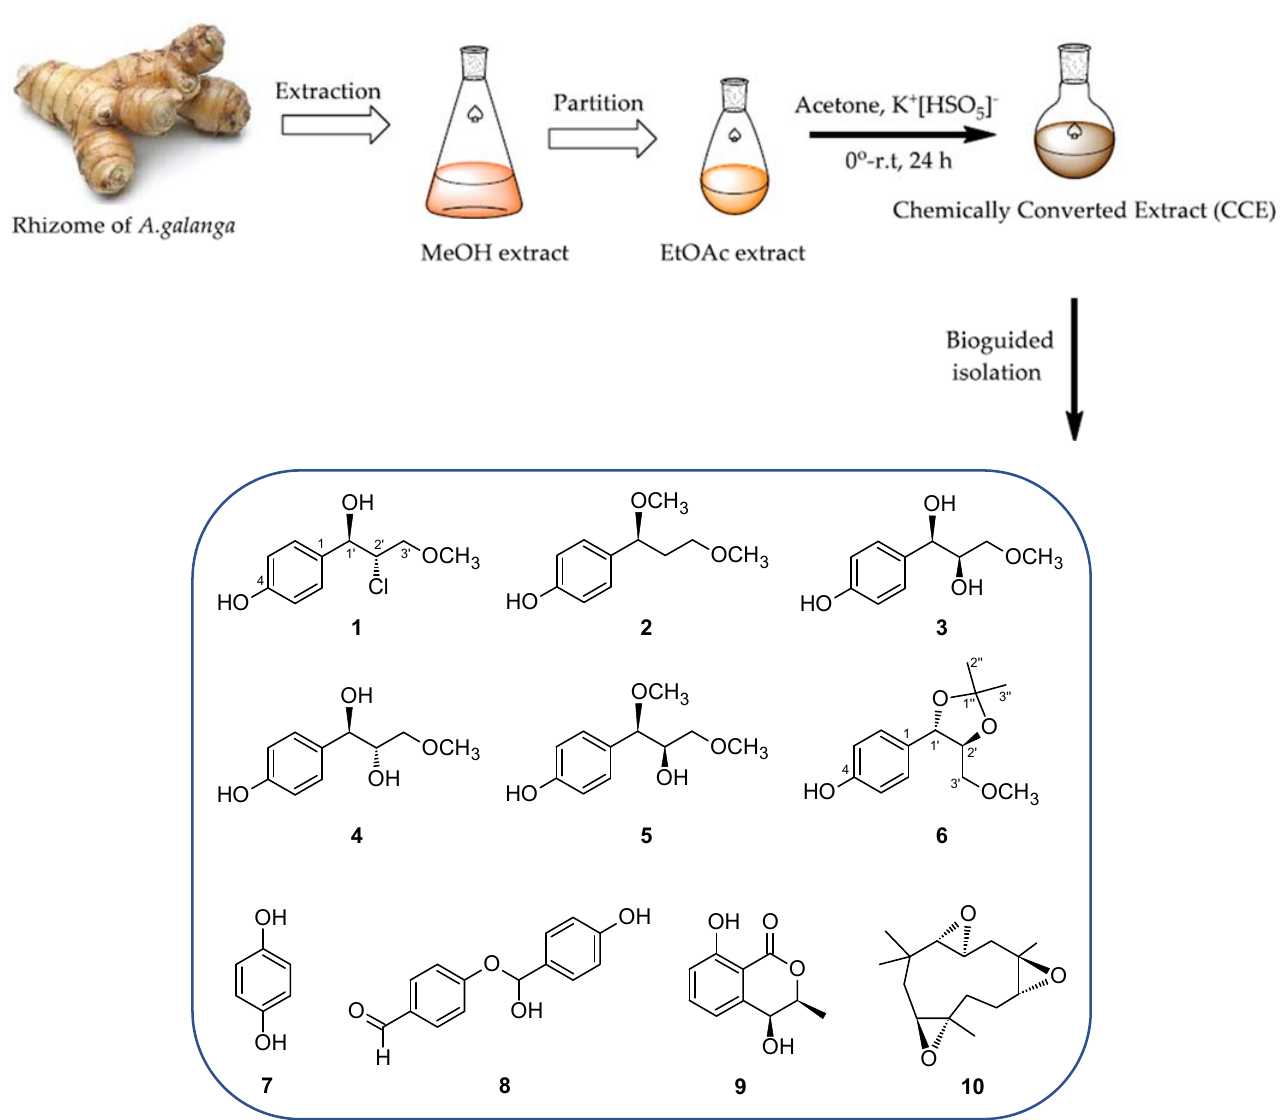
Scheme 1. Isolation of compounds from the chemically converted extract of A.galanga .